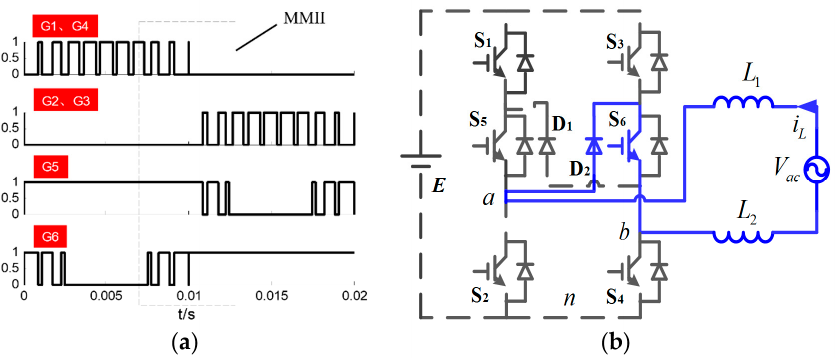
Figure 6. The novel hybrid modulation mode and operation mode 5. ( a ) The new Hybrid Modulation Mode (HMM), ( b ) operation mode 5.